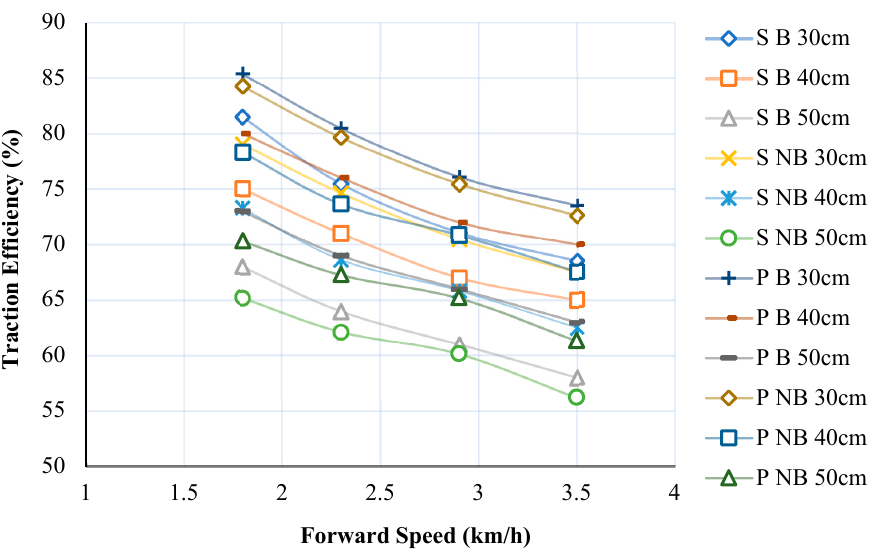
Figure 5. The relationship between speed, depth, vertical load and traction efficiency using studied tines (S—Subsoiler, P—Paraplow, B—225 kg vertical load, NB—No load).